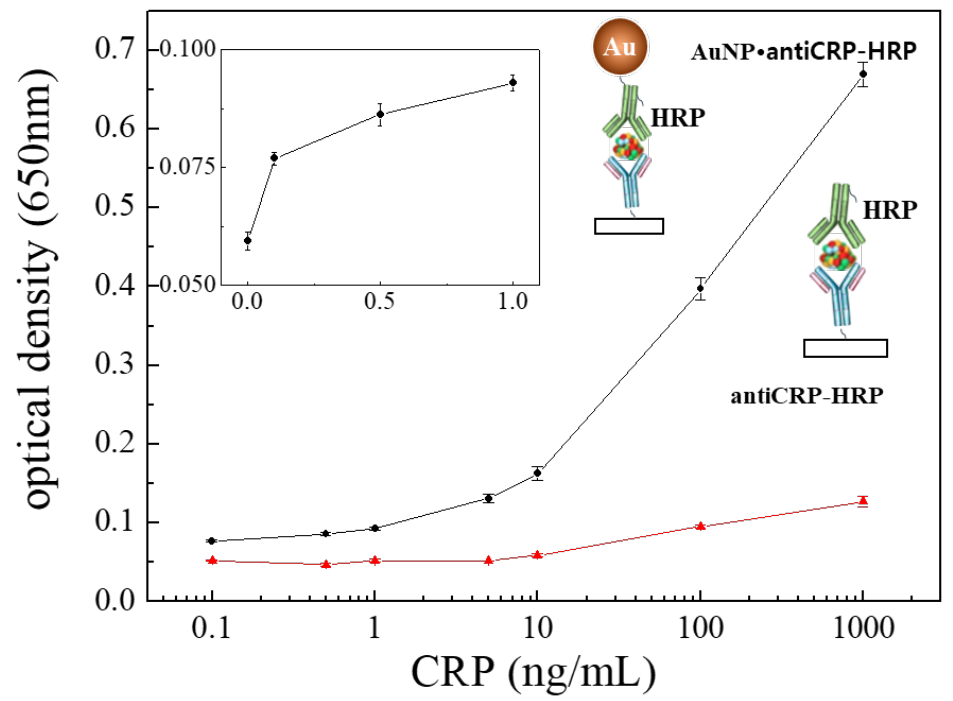
Figure 3. Logarithmic plots of optical density against CRP concentration of the “AuNP ELISA” (AuNP 10 nm) (black line) and the conventional ELISA (red line) with the inset representing the linear plot of the lower concentration range of the “AuNP ELISA”.